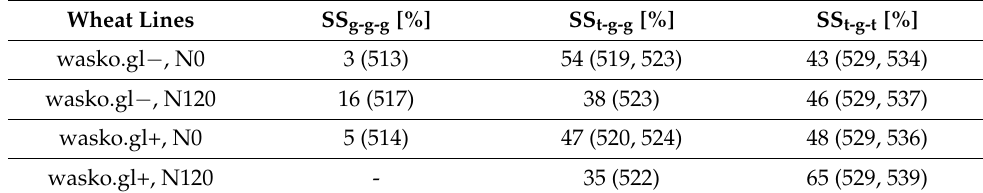
Table 3. Conformations of S-S bridges [%] calculated from FT-Raman spectra of wheat flour of wasko.gl+ and wasko.gl − lines treated with N fertilizers in doses: 0 (N0) and 120 (N120) kg N · ha − 1 respectively. The wavenumbers of the bands’ positions (cm − 1 ), obtained by curve-fitting spectra, are shown in the brackets. N ≥ 3, SD <